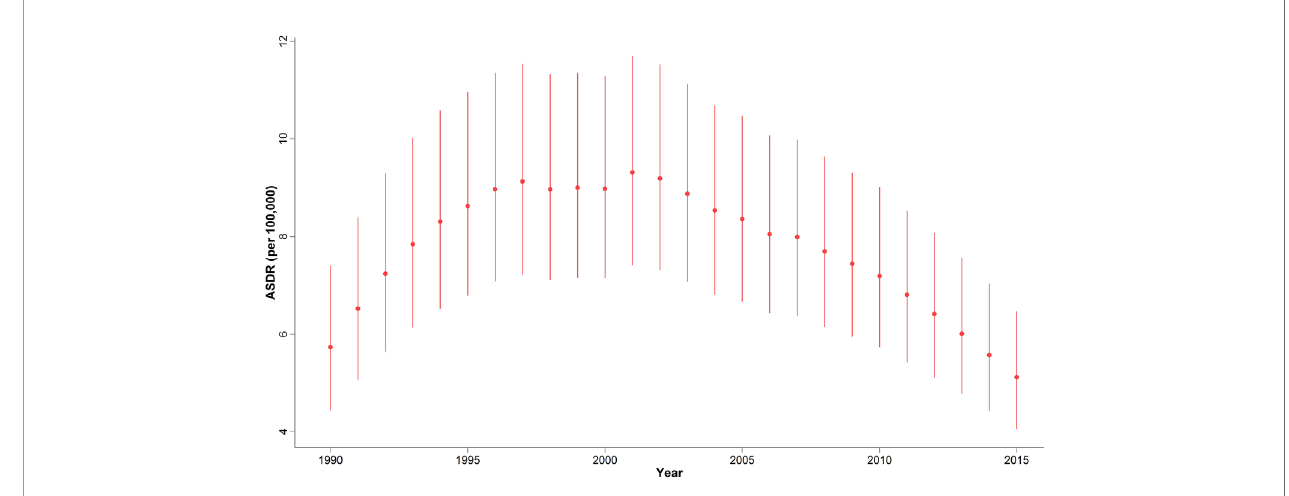
FIGURE 3 | National time trend of ASDR from 1990 to 2015.